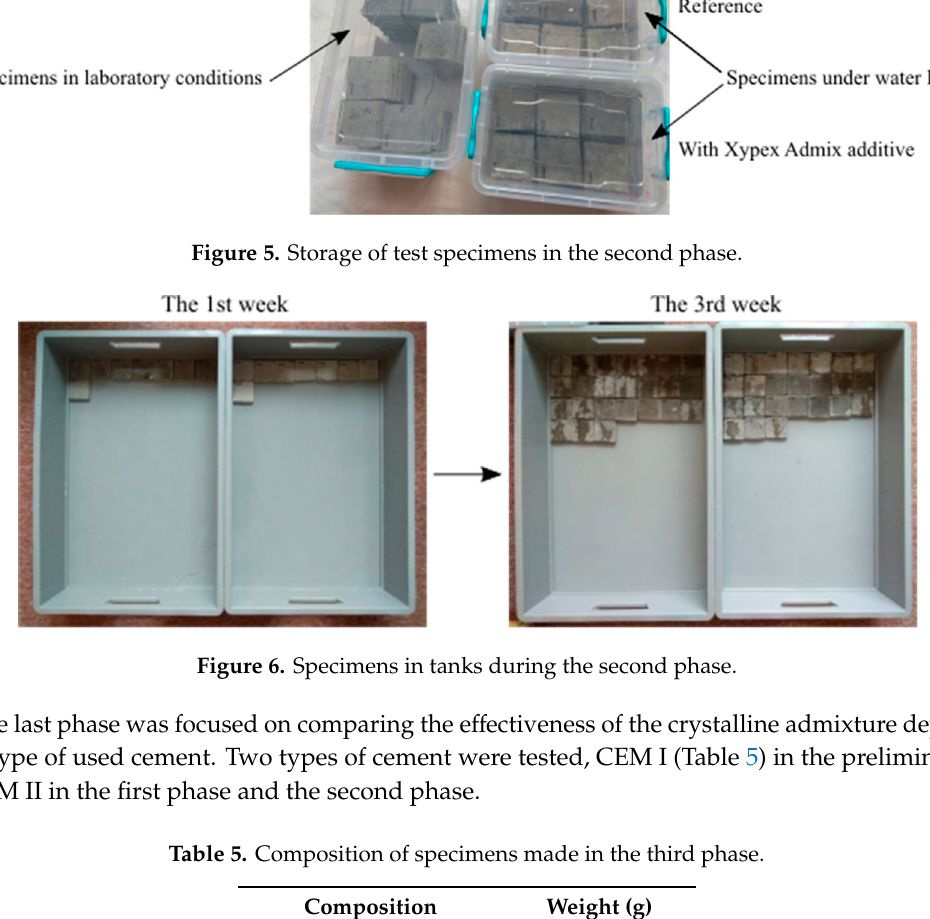
Figure 4. Time schedule of the second phase.